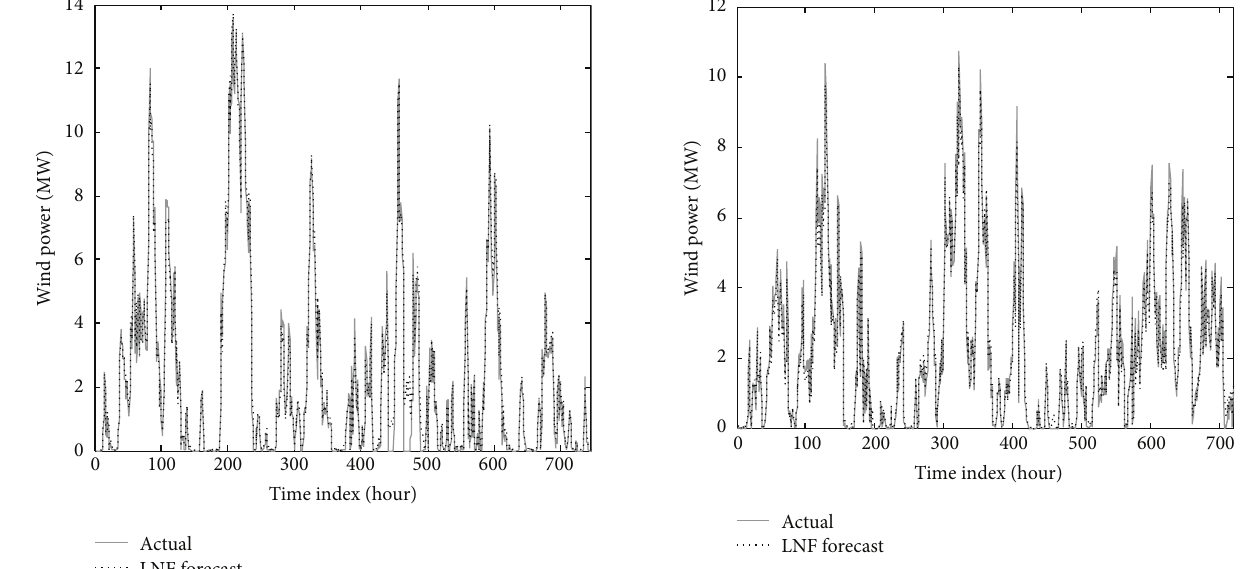
approach used for comparison in wind power forecasting [3, 4]. In the persistence method, the forecast for all future values in the forecast horizon is set to the last measured value [5]. The ARIMA which belongs to the category of classical